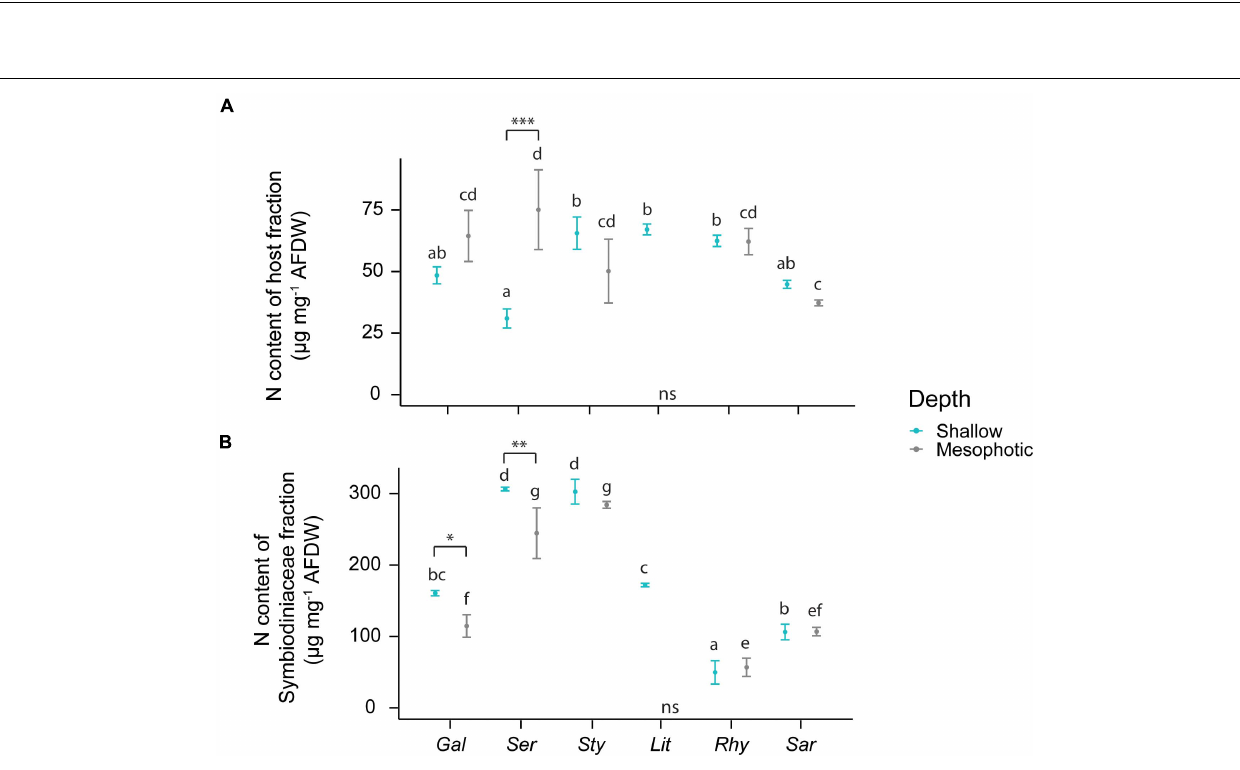
FIGURE 3 | Elemental composition of the host tissue and Symbiodiniaceae fraction in the species investigated. (A) N content of the host tissue. (B) N content of the Symbiodiniaceae fraction. The first three species [ Galaxea fascicularis (Gal), Seriatopora hystrix (Ser), Stylophora pistillata (Sty)] are hard corals and the last three [ Litophyton arboreum (Lit), Rhytisma fulvum fulvum (Rhy), Sarcophyton sp. (Sar)] are soft corals. Significant differences between depths are displayed with asterisks ( ∗ for p < 0.05; ∗∗ for p < 0.01; ∗∗∗ for p < 0.001). Significant differences between species are distinguished with letters by depth. AFDW = ash-free dry weight. ns = not